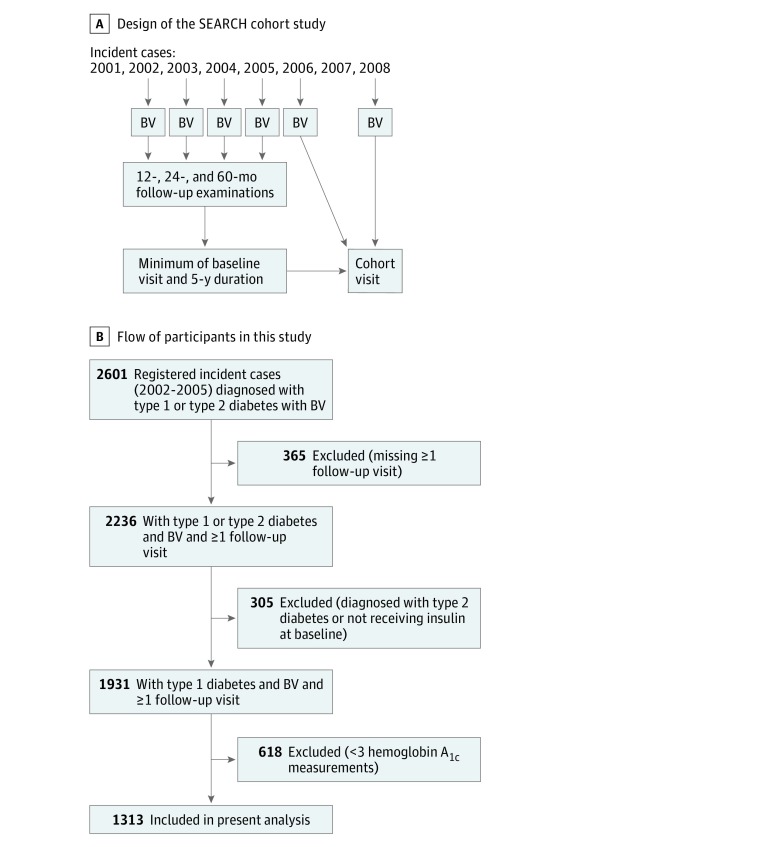
Study Design and Sample RecruitmentA, Study design of the SEARCH cohort study. B, Flowchart depicting participants in this report, including reasons for exclusion. The final sample included 1313 youths with type 1 diabetes. BV indicates baseline visit.